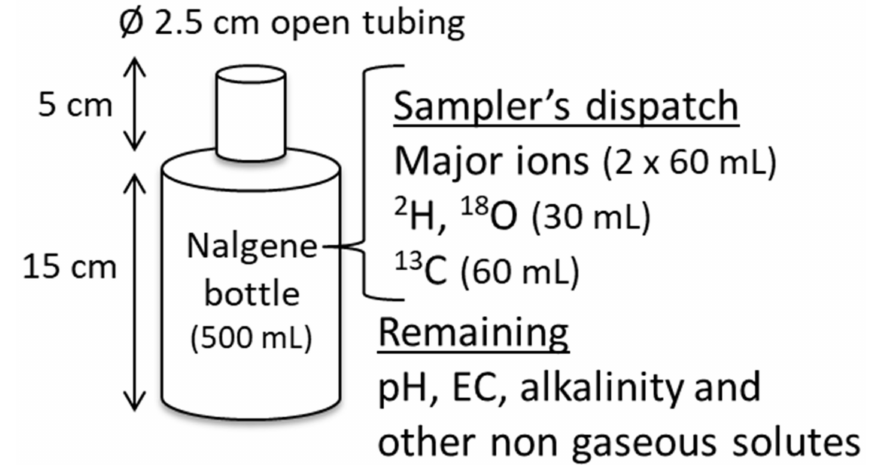
Figure 2. Groundwater passive sampler and dispatch to subsequent vials for